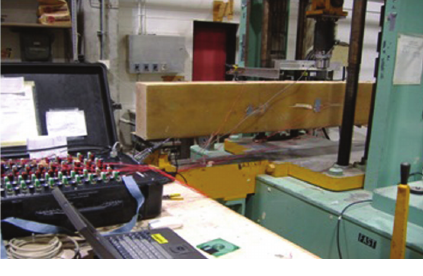
Figure 3: Test setup. Table 1: Specimen testing